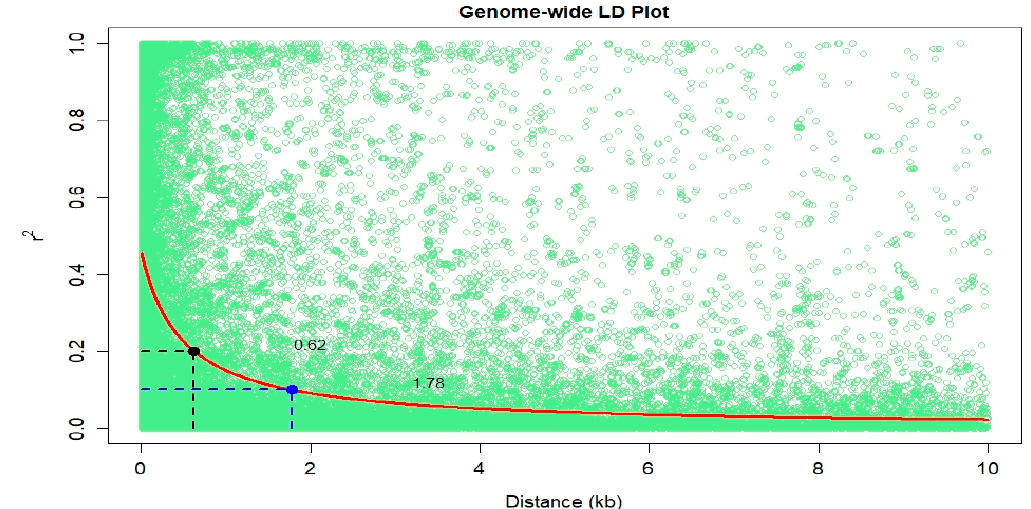
Figure 2. Population structure and PCA plot of 914 maize inbred lines estimated from 5085 SNPs. ( a ) PCA plot for the entire population and colored by the group divisions (DTMA, IMAS, and WEMA). ( b ) Plot of Delta K was calculated for K = 2 to K = 9. ( c ) Population structure of the lines for K = 2 and K = 3.